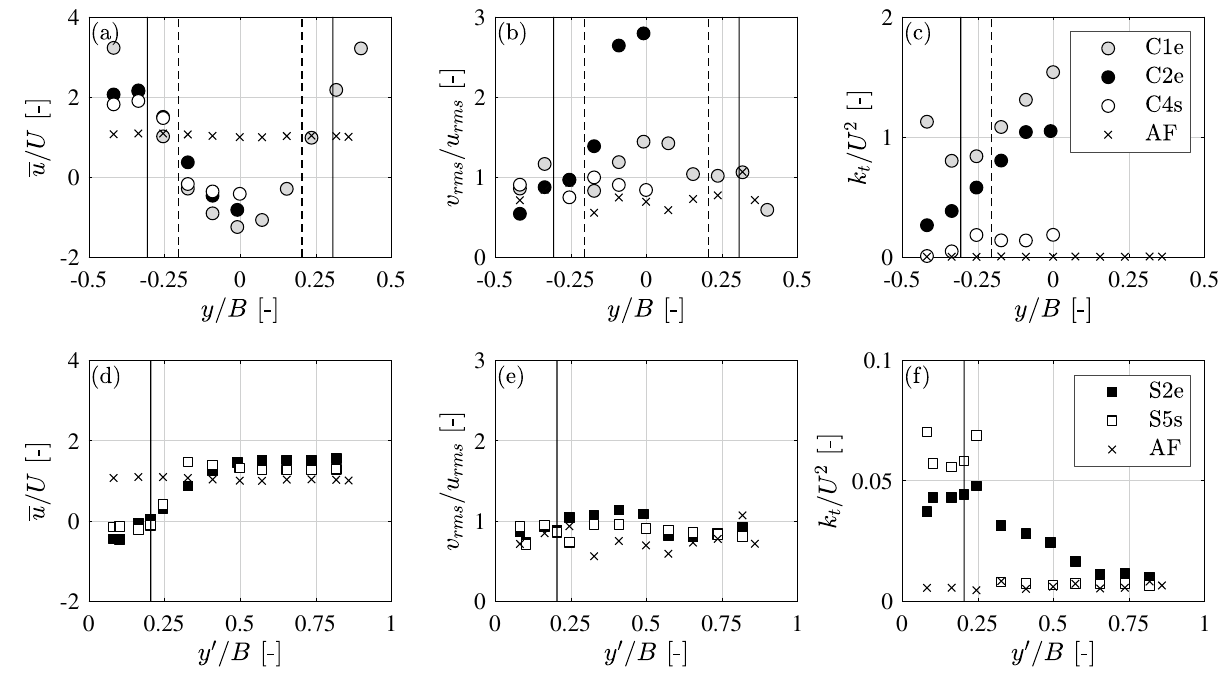
Figure 6. Lateral profiles of time-mean velocity normalized by the channel average velocity ( a , d ), ratio of v rms to u rms ( b , e ) and turbulent kinetic energy normalized by the square of channel average velocity ( c , f ) for logs placed at center ( a – c ) and at the side ( d–f ). Approach flow conditions (AF) included for reference; log center at y/B = 0 (placed at channel center) and channel wall at y’/B = 0 (placed at channel side). B is the channel width. Note that the range on the vertical axis in ( c ) is 20 times greater than in ( f ). The vertical lines indicate the log ends. For ( a , b ) and ( d – e ) ( u and v rms / u rms ), the lateral profile was taken at the x -location at which flow velocity was minimum. For ( c ) and ( f ) ( k t ), the x -location corresponded to the peak k t